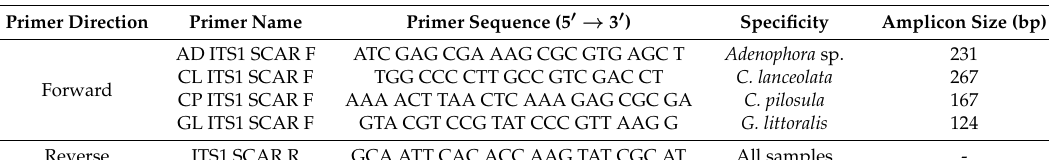
Table 3. Sequences of the ITS1-SCAR primers and their specificity, amplicon sequence, and amplicon size.